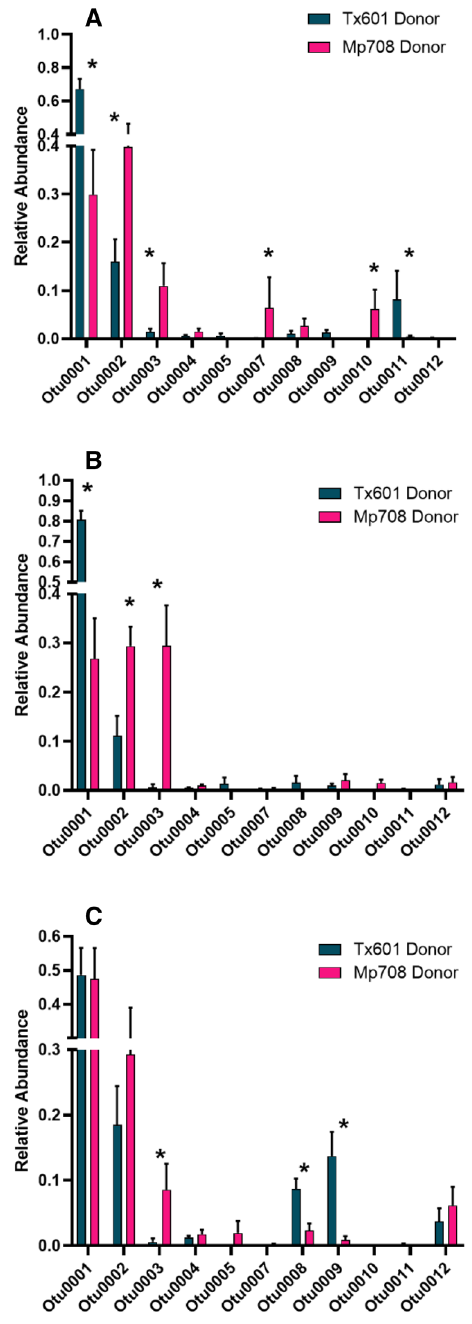
Figure 4. Relative abundance of more prevalent (> 97% of read relative abundance) OTUs from the gut of fall armyworm fed on susceptible B73 ( A ), susceptible Tx601 ( B ), and resistant Mp708 ( C ) maize foliage. Donor indicates the feeding substrate of the fall armyworm larvae that provided frass for transfer to recipients. Asterisks represent significant differences in OTU relative